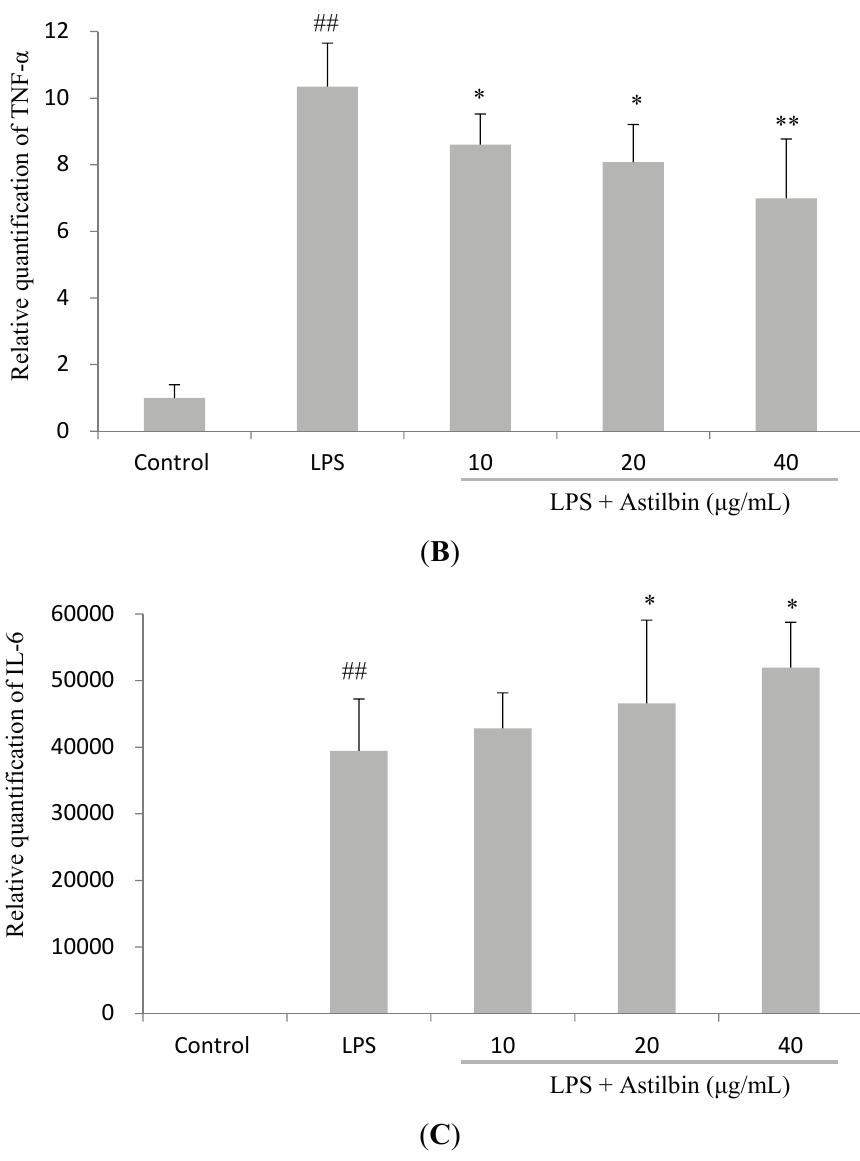
Figure 3. Inhibitory effect of astilbin on iNOS, TNF- α and IL-6 mRNA expressions in LPS-induced RAW264.7 cells. Cells were pretreated with different concentrations of astilbin for 2 h, and then stimulated with LPS (0.1 µg/mL) for 12 h. The relative iNOS ( A ), TNF- α ( B ) and IL-6 ( C ) mRNA expression was performed by real-time RT-PCR, and results were expressed as the ratio of the optimal density relative to glyceraldehydes 3-phosphate dehydrogenase (GAPDH). ## p < 0.01 compared to the control group, while * p < 0.05 and ** p < 0.01 compared to the LPS-treated